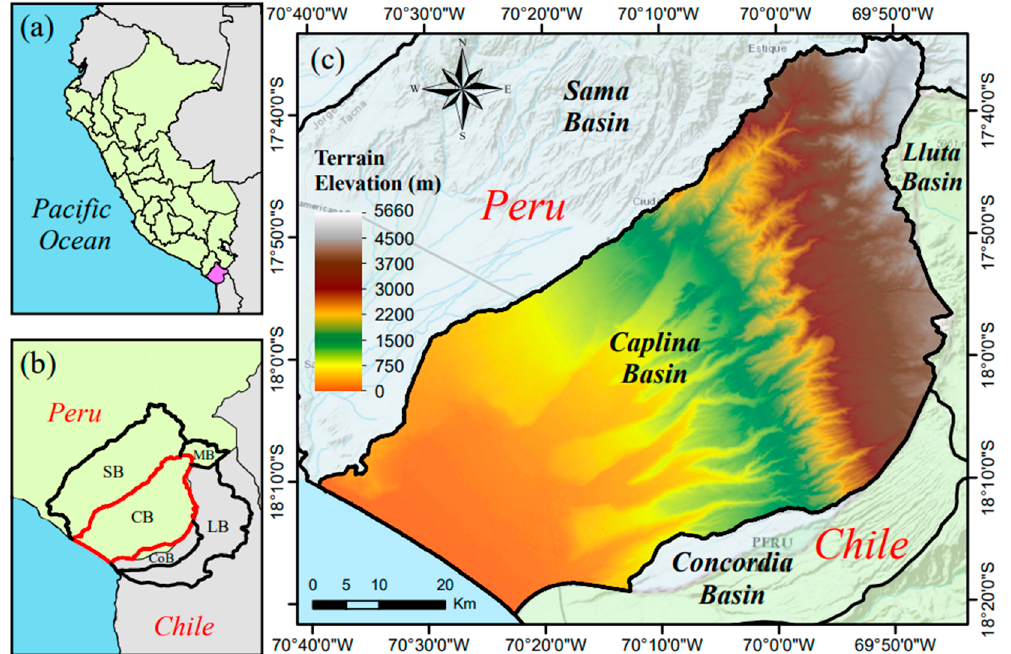
Figure 1. Location map of the study area ( a ) Tacna, Peru. ( b ) Adjacent basins, SB: Sama basin, MB: Maure basin, LB: Lluta basin, CoB: Concordia basin and CB: Caplina basin. ( c ) Geographical location of the Caplina basin, Atacama Desert.